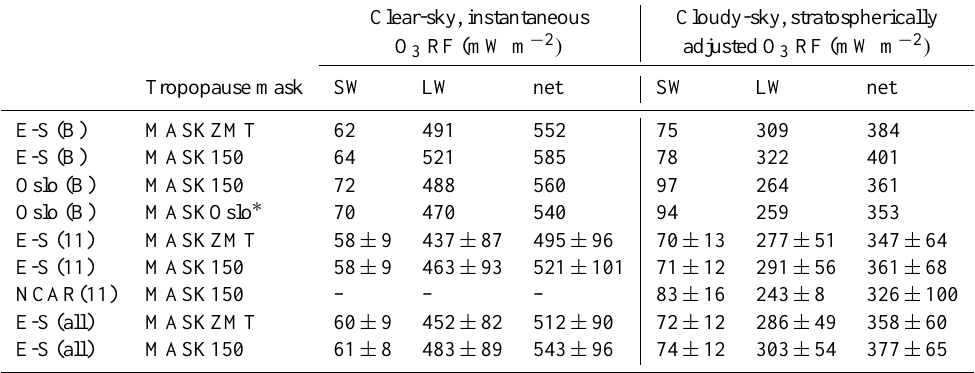
Table 5. Comparison of ozone RFs from different radiation schemes for both the clear-sky, instantaneous case, and cloudy-sky, stratospheri- cally adjusted case. Results are shown for model B alone (to allow direct comparison of E-S and Oslo schemes), 11 models (ACEFGIKLMNP; to allow direct comparison of E-S and NCAR schemes), and all models (for